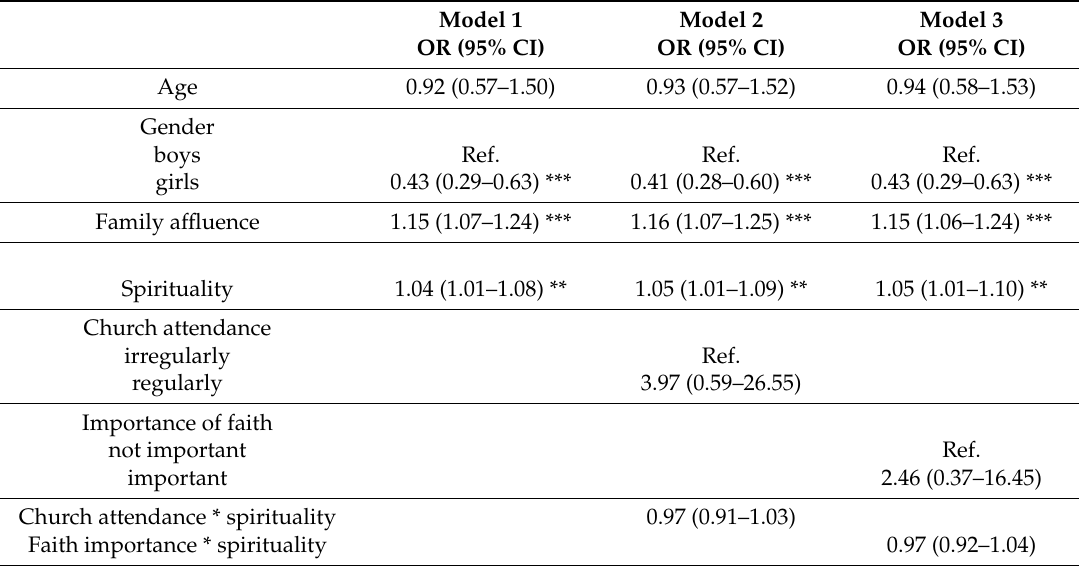
Table 4. Logistic regression with ORs and 95% CI of the association between spirituality and